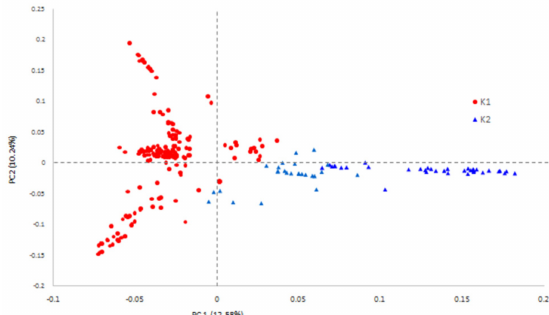
Figure 3. The PCA of G. soja .